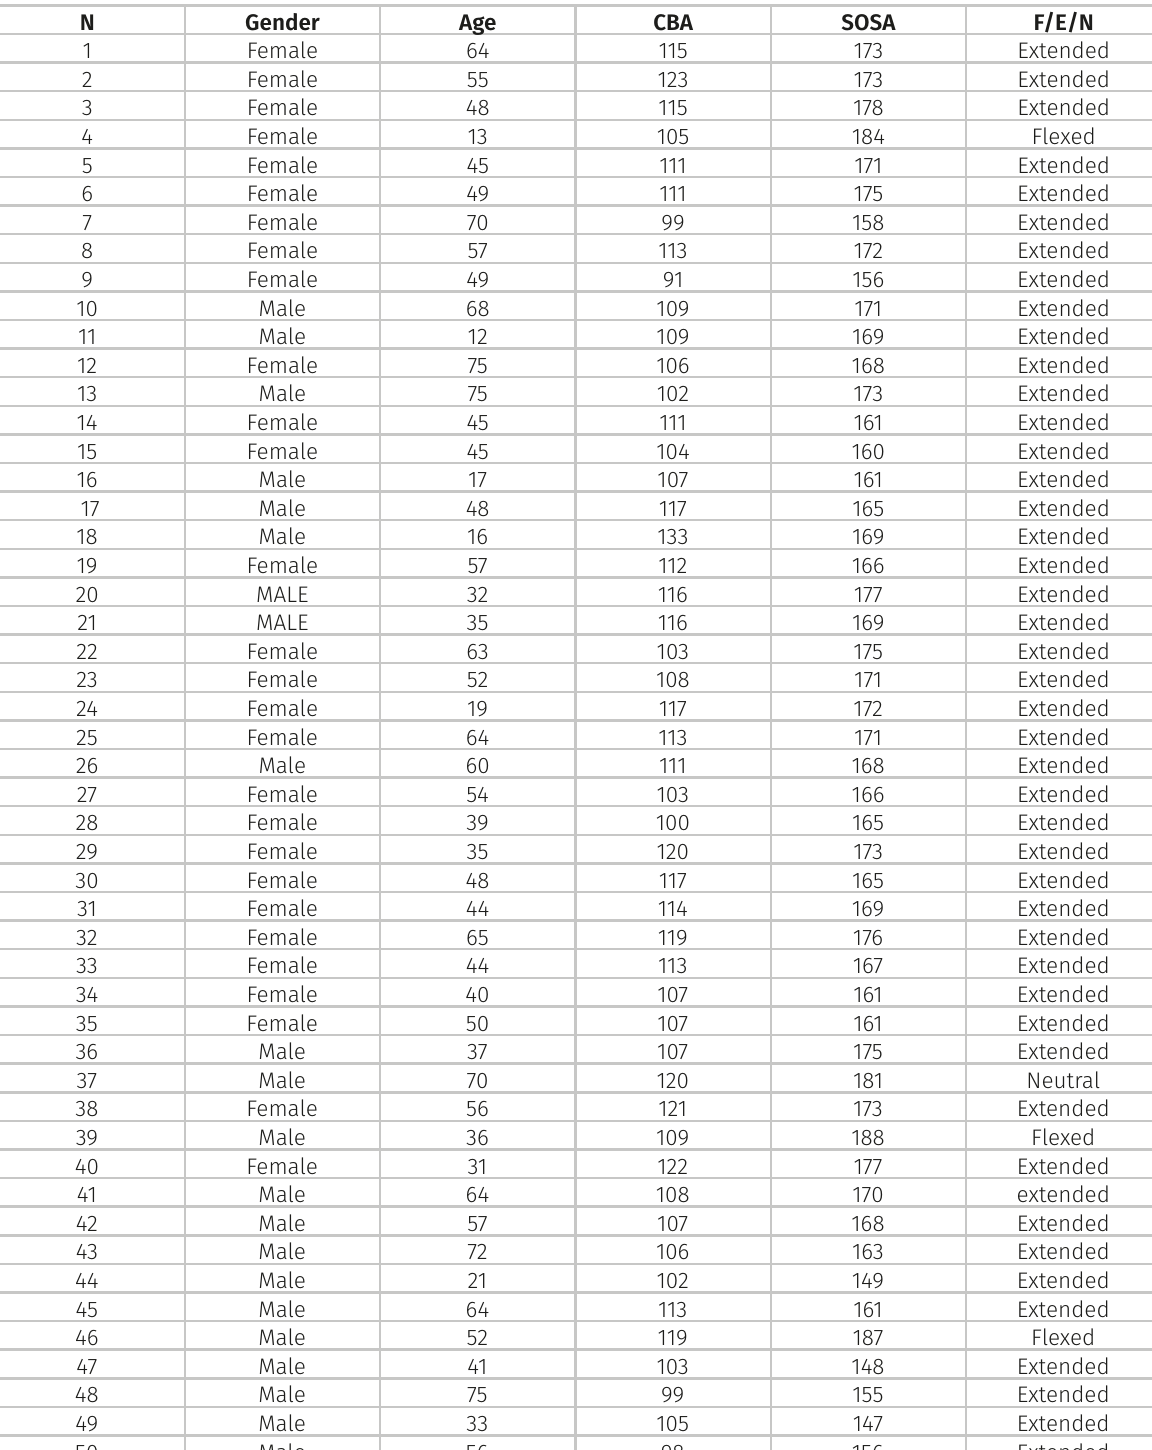
Table I. Demographic data: age and gender. Angles values. Classification of SOSA in flexed, extended or neutral.